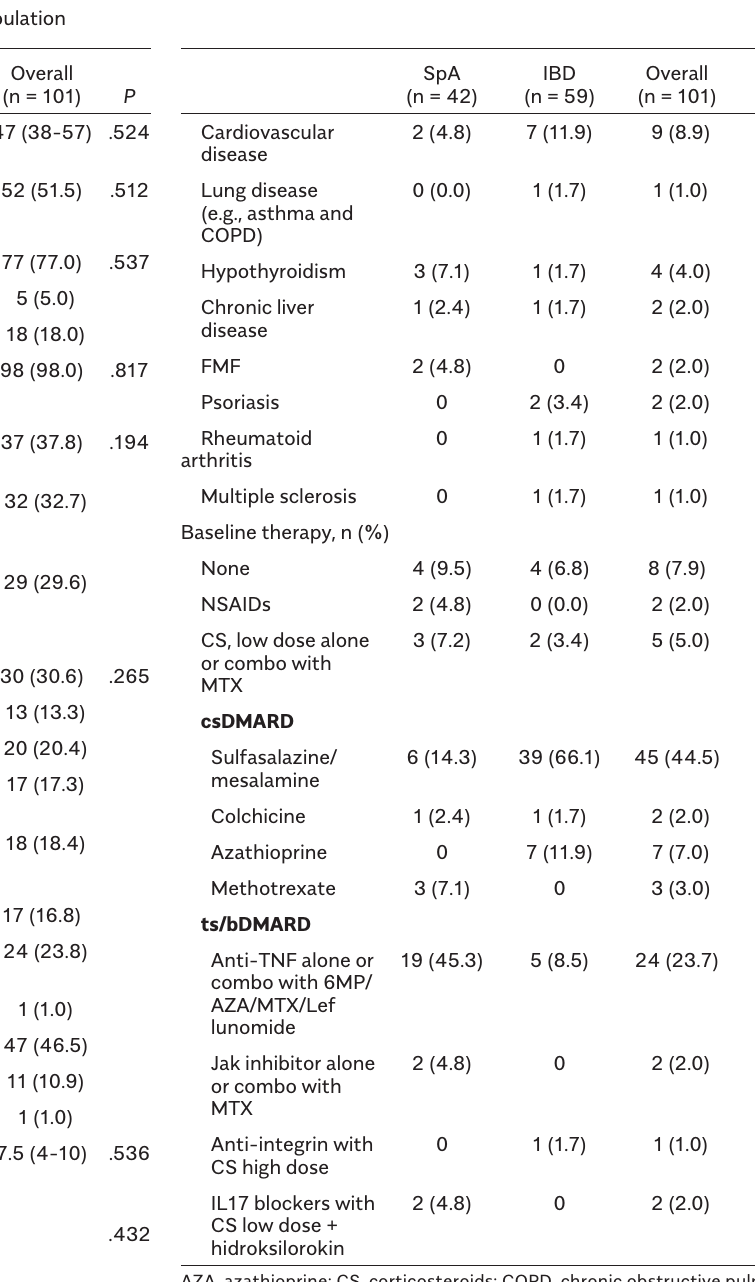
Table 1. Baseline Characteristics of the Study